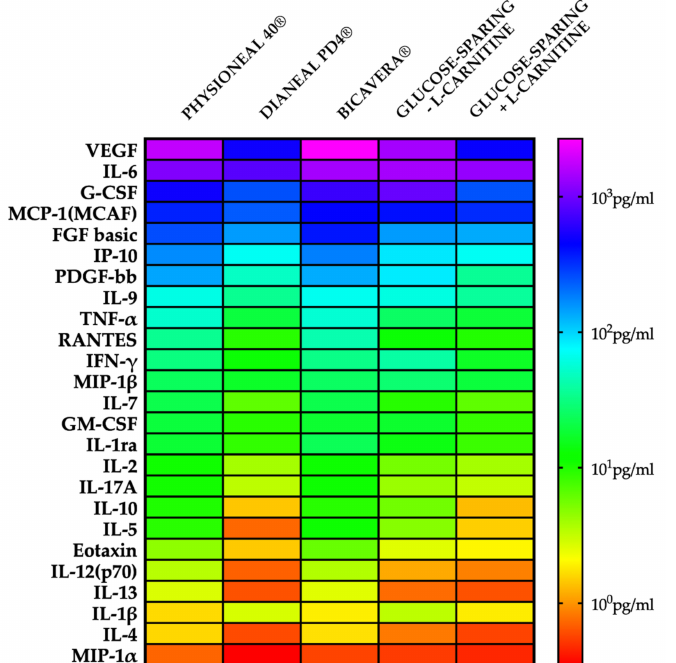
Figure 3. Cytokines, chemokines and growth factors released from the apical side by HMC incubated with high osmolarity PD solutions. A heatmap shows the result of a quantitative 27-plex Luminex assay. The concentration (pg/ml) increases as the color changes from red to